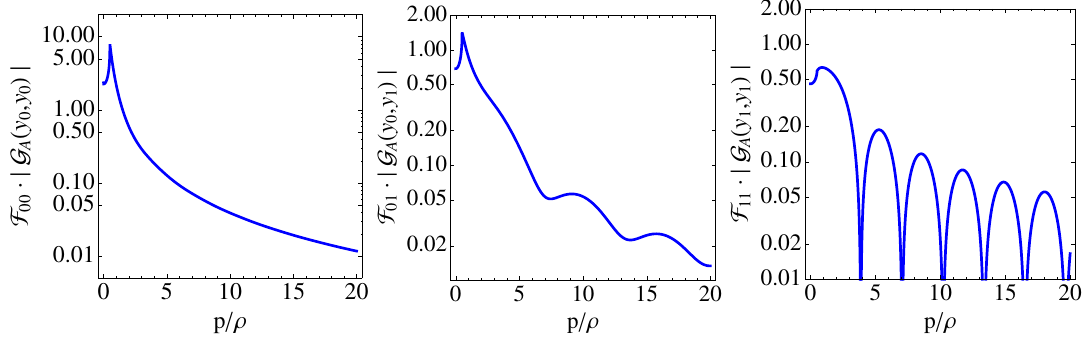
Figure 2 . Plots of the rescaled Green’s functions F 00 ·|G A ( y 0 , y 0 ; p ) | (left panel), F 01 ·|G A ( y 0 , y 1 ; p ) | (middle panel), and F 11 · |G A ( y 1 , y 1 ; p ) | (right panel) as functions of p/ρ . We have used A 1 = 35 in all panels and assume time-like momenta p 2 > 0 .